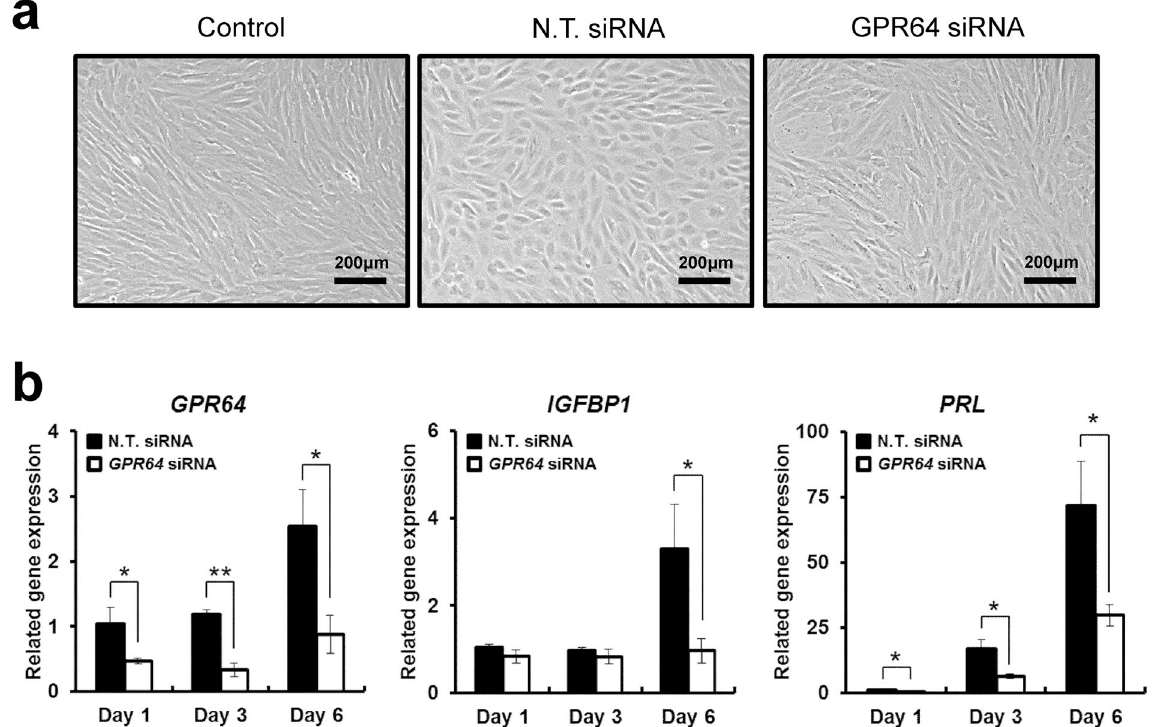
Figure 5. Effect of GPR64 knock-down during in vitro decidualization of hESCs. ( a ) Morphological change of hESCs treated with or without GPR64 siRNA after in vitro decidualization treatment for 6 days. Control is non-treatment with in vitro decidualization to hESCs. ( b ) The expression levels of GPR64 were examined on hESCs treated with or without GPR64 siRNA during in vitro decidualization using quantitative real-time PCR. Expression of decidualization marker genes, IGFPB1 and PRL were examined during in vitro decidualization of hESCs treated with or without GPR64 siRNA. The results represent the mean ± SEM. * p < 0.05. The results represent the mean ± SEM. * p < 0.05 and ** p <